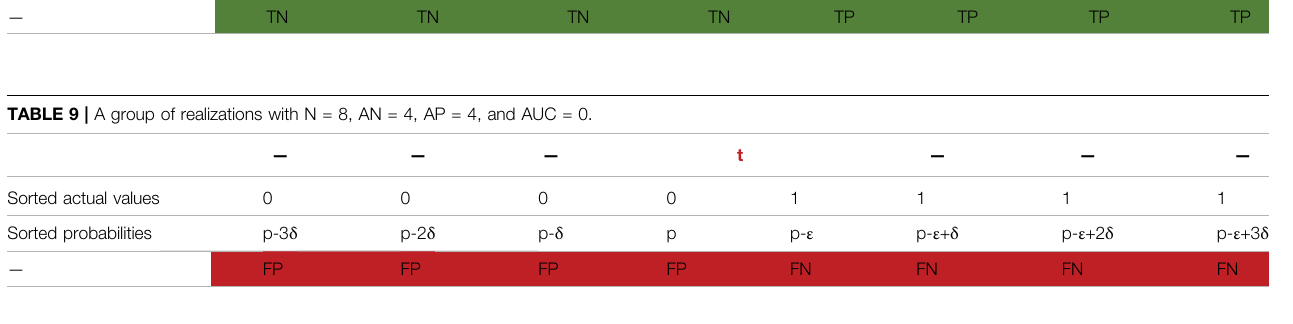
TABLE 8 | A group of realizations with N (cid:1) 8, AN (cid:1) 4, AP (cid:1) 4, and AUC (cid:1) 1. — — — t — — — Sorted Actual Values 1 1 Sorted Probabilities —